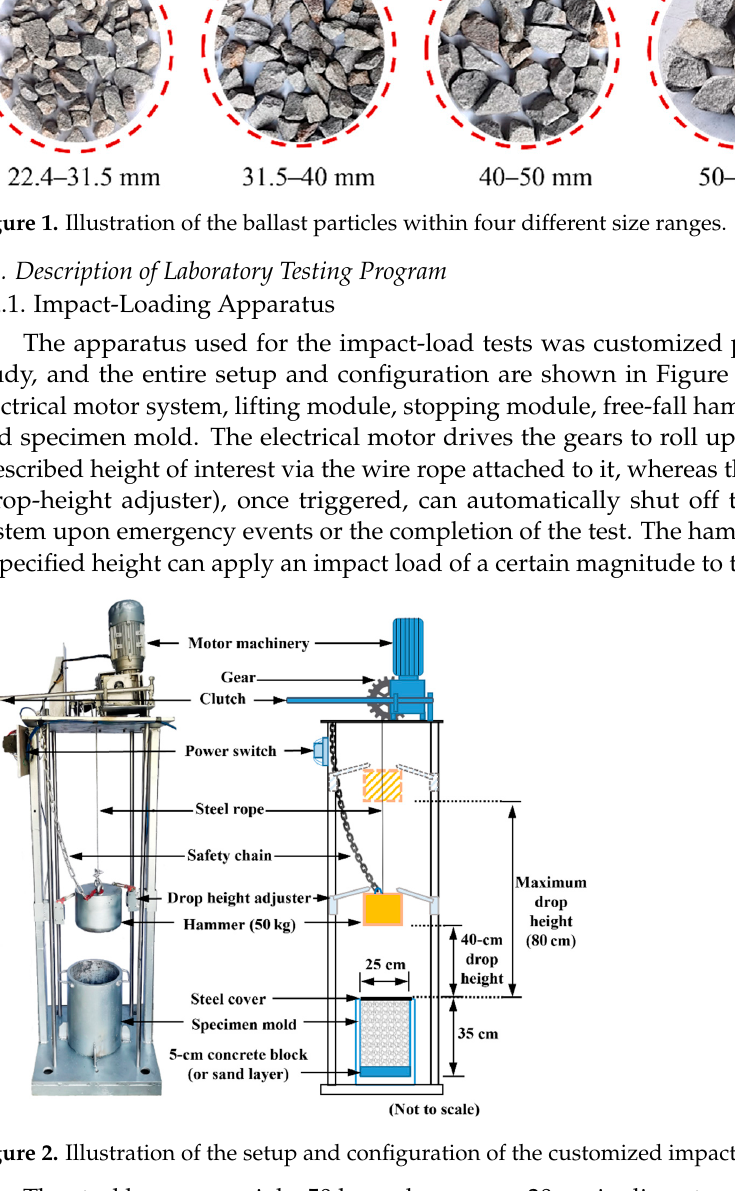
Figure 3. Illustration of reconstructing digital 3D models of selected ballast particles and calculating their shape indices.